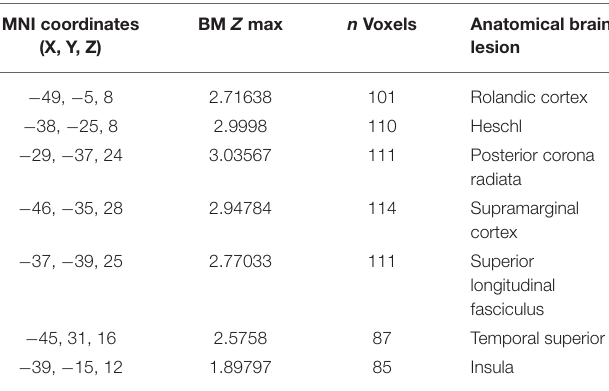
TABLE 2 | Total aphasia quotients associated with stroke